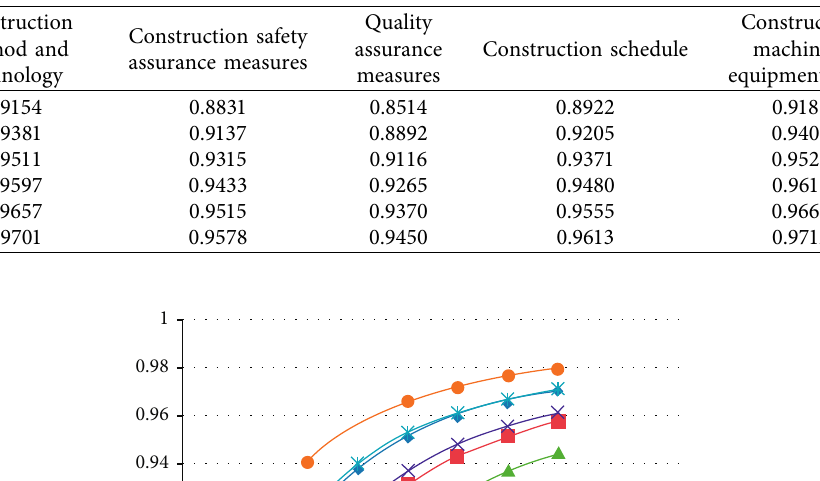
Table 7: The value of the generalization coefficient in the study.